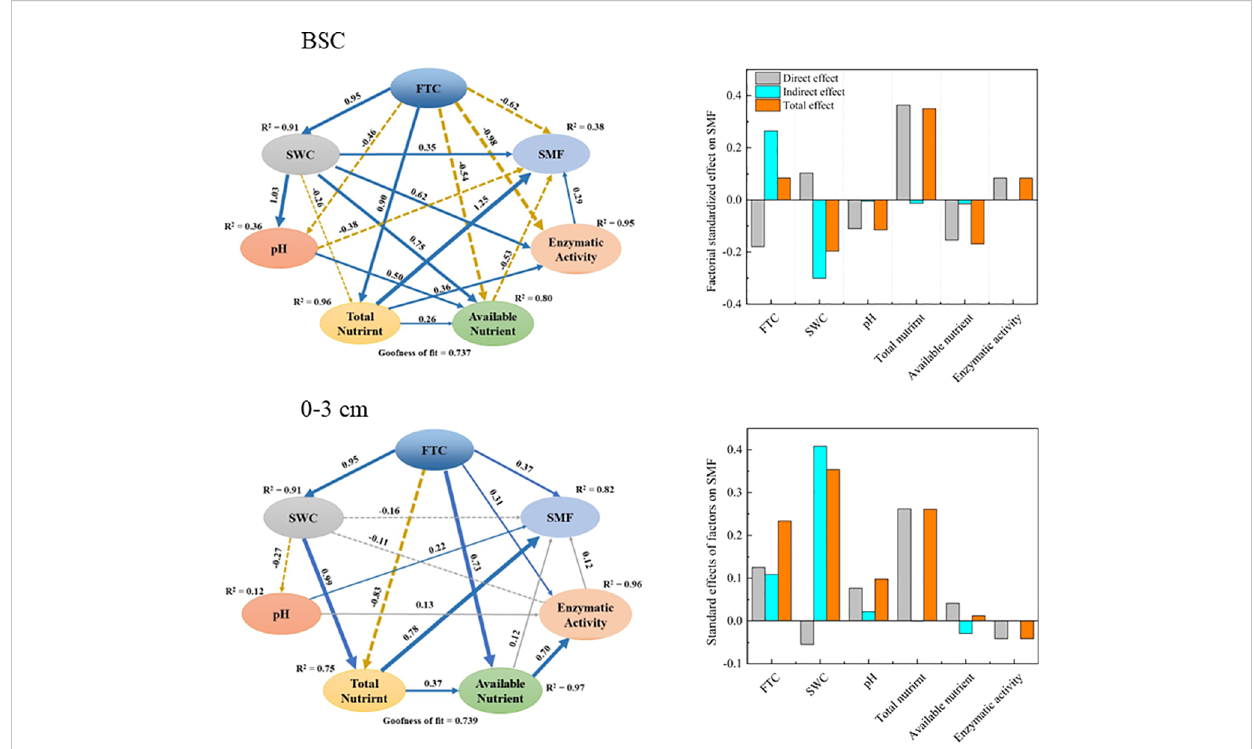
FIGURE 5 Partial least squares pathway model (PLS-PM) of soil nutrient multifunctionality (SMF) and environmental factors. The model illustrates the effects and pathways of FTC, soil water content (SWC), pH, total nutrients, available nutrients, and extracellular enzyme activity on soil nutrient multifunctionality. The blue solid and brown dashed arrows depict the direct positive and negative effects of causality (P < 0.05), and the gray solid and dashed arrows show the direct positive and negative effects of causality (P > 0.05), respectively.